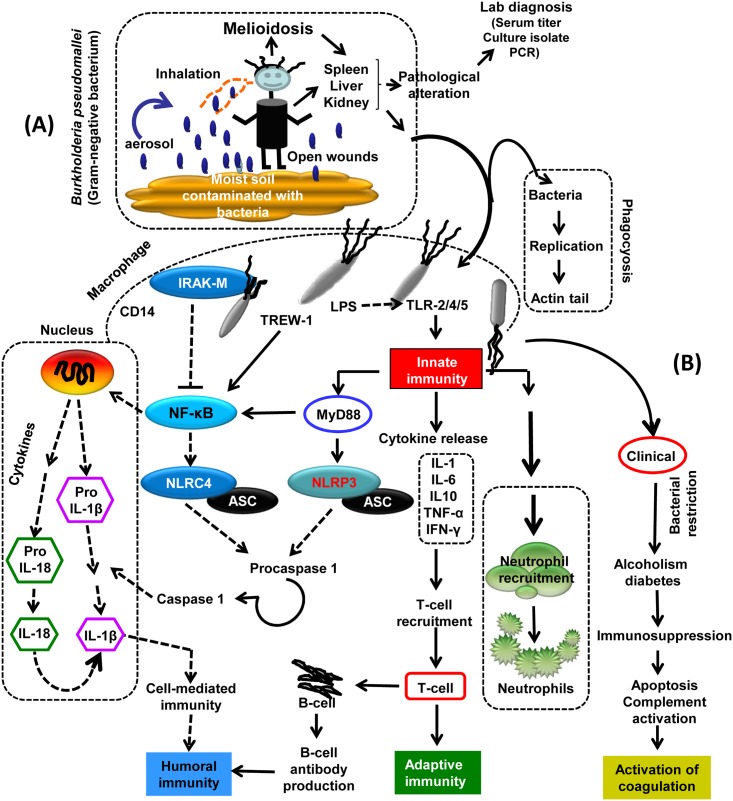
Schematic representation showing the virulence and pathogenesis of melioidosis infection.B. pseudomallei is transmitted from its environmental reservoir to lung epithelial cells, where it initially attaches, possibly through bacterial components such as the capsule and type IV pili. Following invasion of epithelial cells, the T3SS-3 effectors assist in vacuolar escape and intracellular motility due to BimA-mediated actin polymerization. The activation of TLR-2, TLR-4, and TLR-5 by bacterial LPS and flagella results in recruitment of innate immune cells, such as neutrophils, macrophages, and natural killer cells. IRAK-M, interleukin-1-associated kinase 3; TLR, toll-like receptor; LPS, lipopolysaccharide; CD14, cluster of differentiation; NF-kB, nuclear factor kappa-light-chain-enhancer of activated B cells; IL, interleukin; TNF-α, tumor necrosis factor alpha; NLRC-4, NRL family CARD domain-containing protein 4; NLRP3, NACHT, LRR, and PYD domain-containing protein 3; ACS, acetyl-CoA synthetases; PCR, polymerase chain reaction.